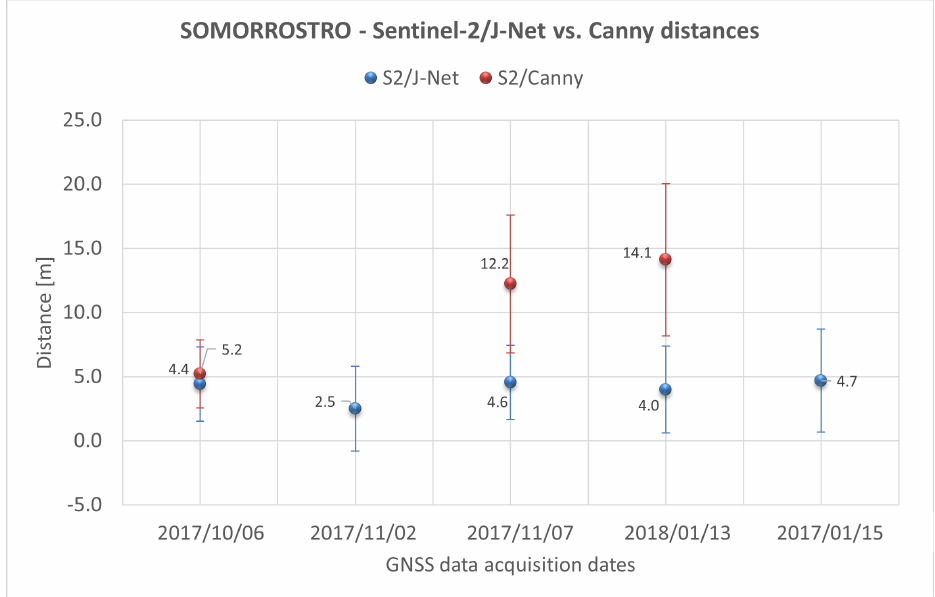
Figure A3. Comparison between the mean distance and standard deviation for each date on Sentinel-2 imagery considering J-Net Dynamic and Canny algorithms in